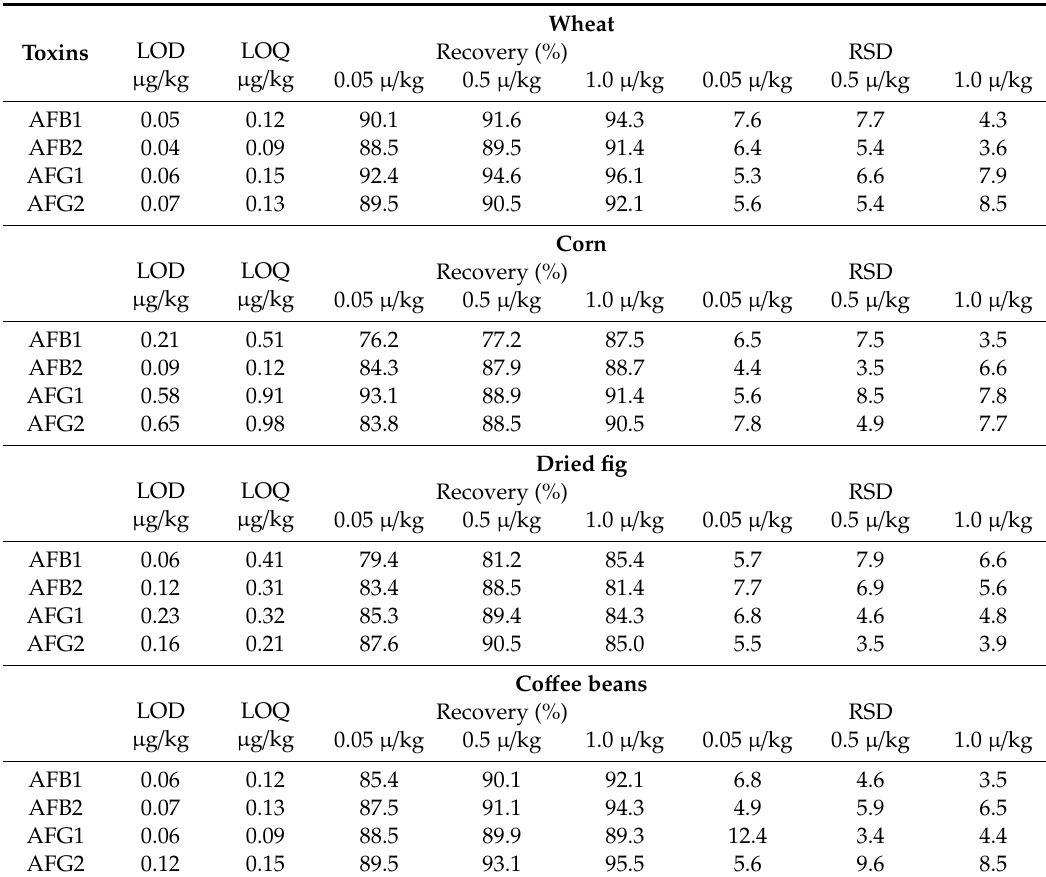
Table 3. Statistical parameters for the determination of AFB1, AFB2, AFG1, and AFG2 in di ff erent food samples by using ELISA techniques.